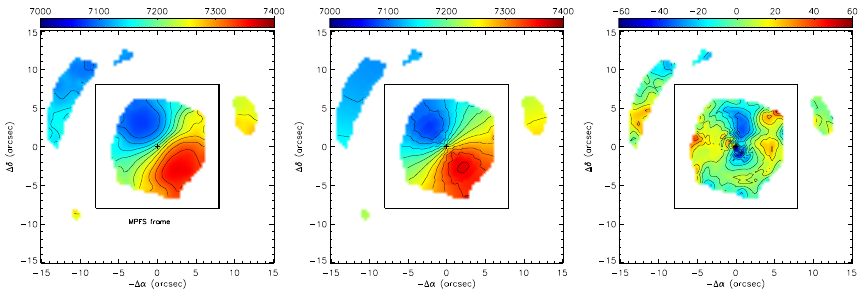
Fig. 2. Mrk 198: the velocity (cid:12)eld of H (cid:11) emission derived from the FPI data (left), a titled-ring model of the circular rotation (middle) and the residual velocity map (right).